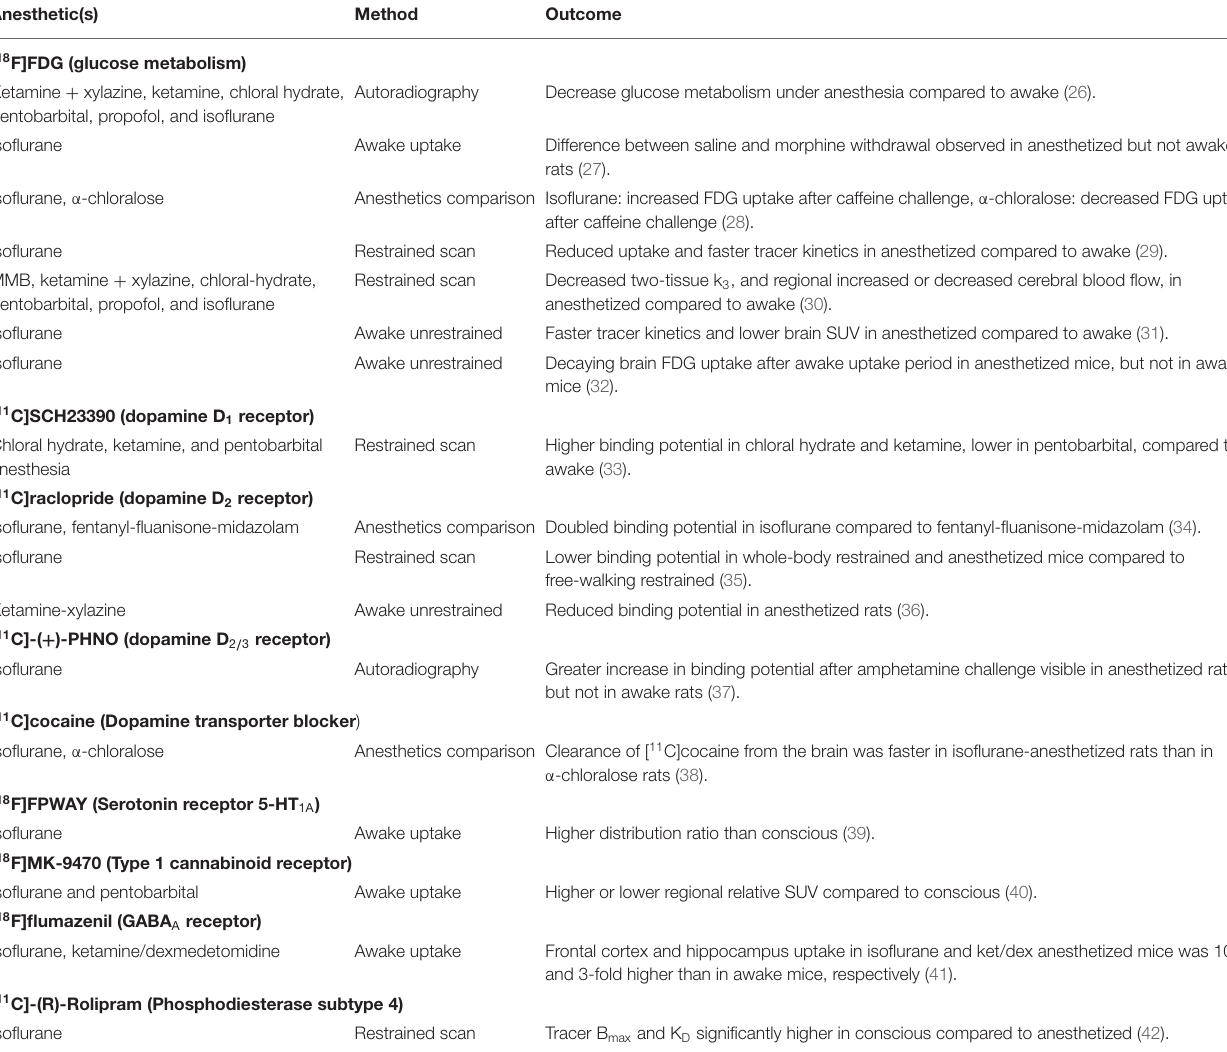
TABLE 1 | Summary of the studies investigating the effect of anesthetic agents in PET brain radiotracers. Anesthetic(s) Method Outcome